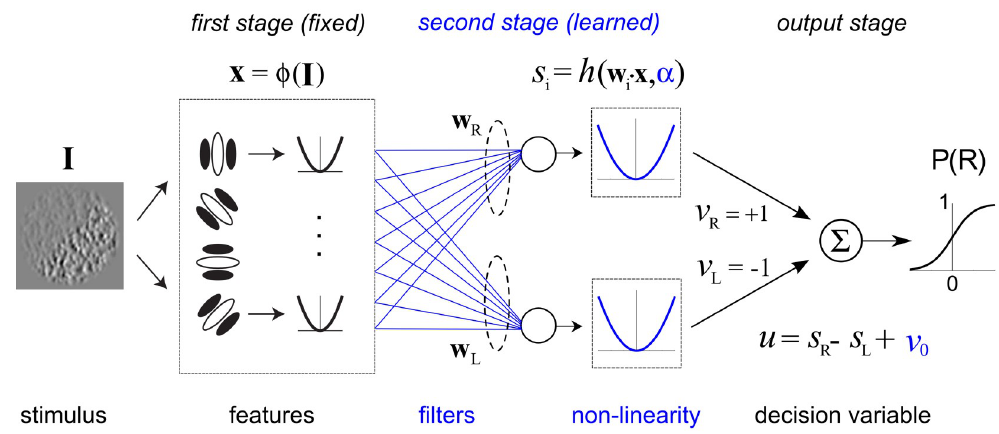
Fig 2. Neural network model implementing a FRF (Filter-Rectify-Filter) arrangement for texture segmentation. Parameters shown in blue are learned from data, those in black are fixed. Stimulus image I is filtered by a bank of first-stage energy filters, resembling V1 complex cells, whose downsampled responses provide a feature vector input x to two second- stage filters. An optimization algorithm adjusts connection weights w L , w R (blue lines), producing second-stage filters which are selective for left-oblique (L) or right-oblique (R) contrast-defined boundaries, to give responses consistent with human psychophysical data. The output of each second-stage filter is passed through a nonlinearity h ( u ) = | u | α (blue curve) whose shape parameter α is also estimated from the psychophysical data. Fixed output weights v R = +1, v L = -1 lead to the decision variable u = s R − s L + v 0 , which is input to a sigmoid function to determine the probability of the observer classifying a given boundary as being right-oblique.